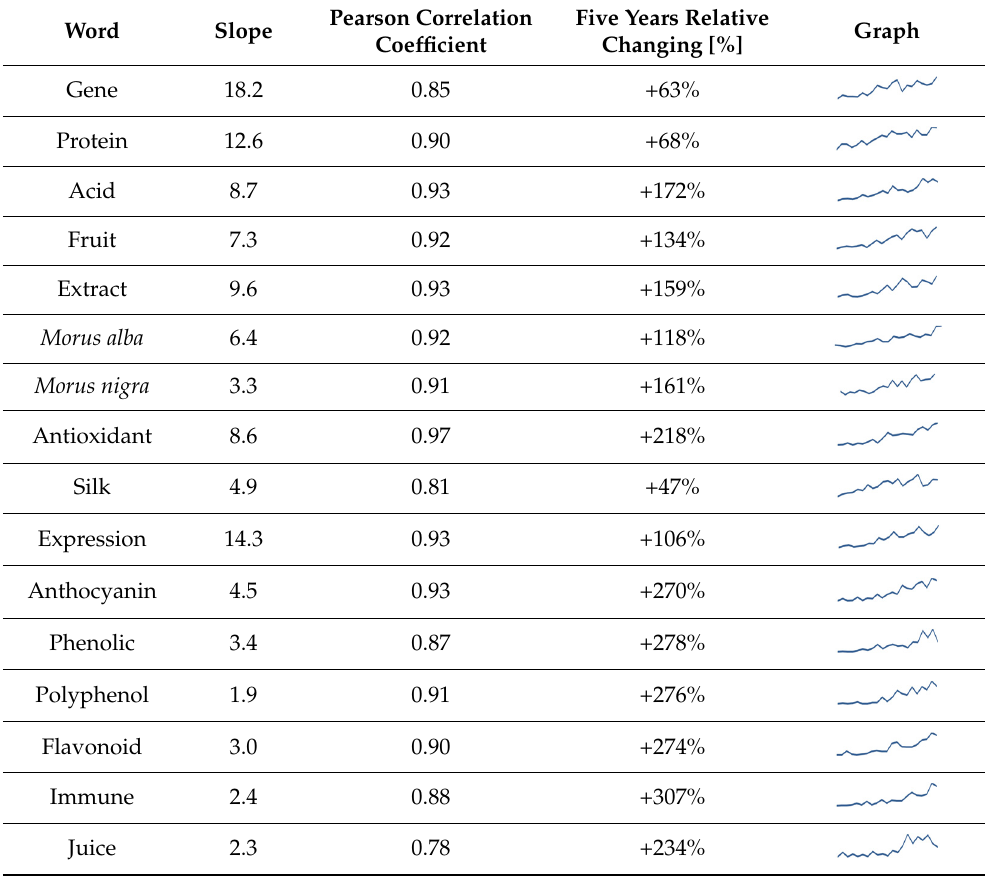
Table 4. The most important words considering their slope, Pearson correlation coefficient and their relative increment in the past five years.